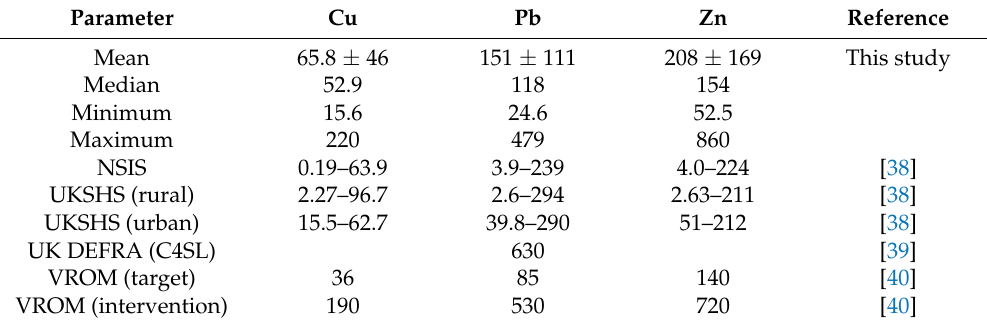
Table 2. Concentrations of copper, lead and zinc in soils from Scottish schools (mg · kg − 1